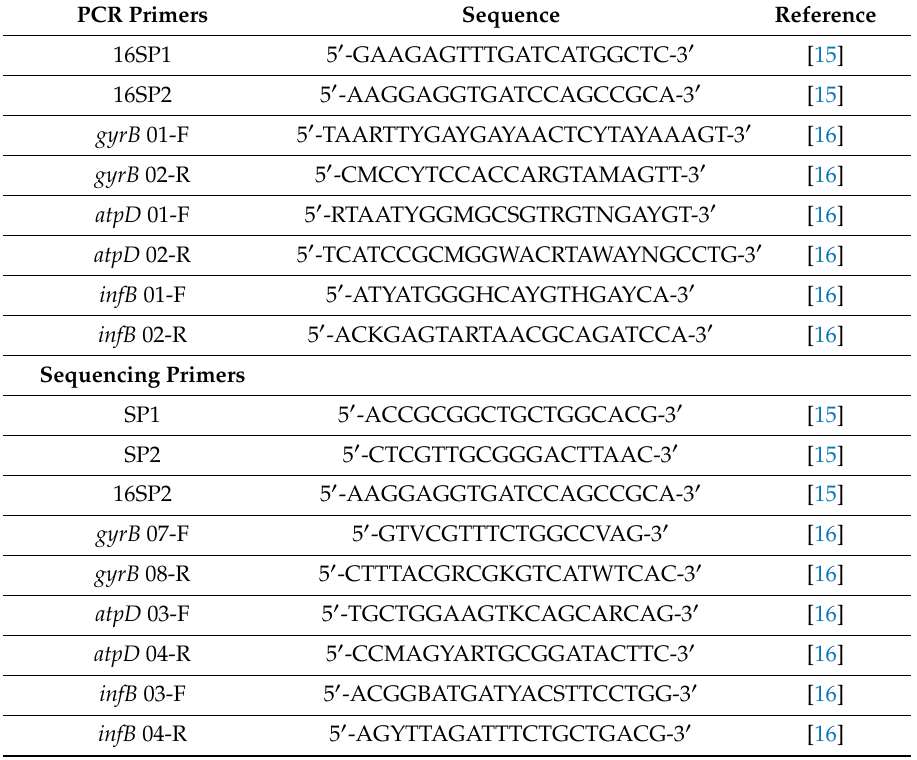
Table 1. Primers used in this study to amplify and sequence 16S rRNA gene and housekeeping genes ( gyrB , atpD and infB ) from ILFE-LP1 bacterial strain isolated from a Populus × euramericana cl. “I-214” tree with symptoms of a bacterial canker in Serbia. PCR